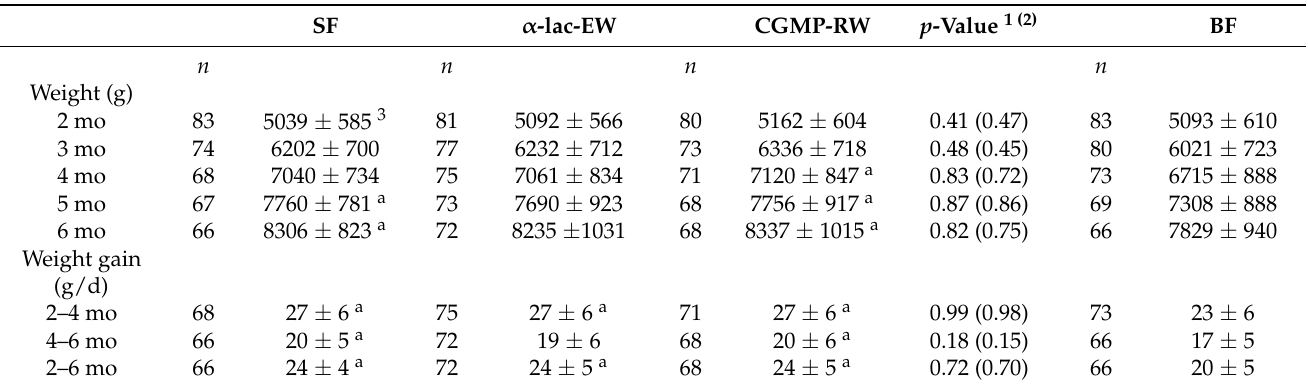
Table 5. Mean weight and weight gain in infants fed formula (SF, α -lac-EW or CGMP-RW) * or breast milk (BF) during the intervention, PP population.